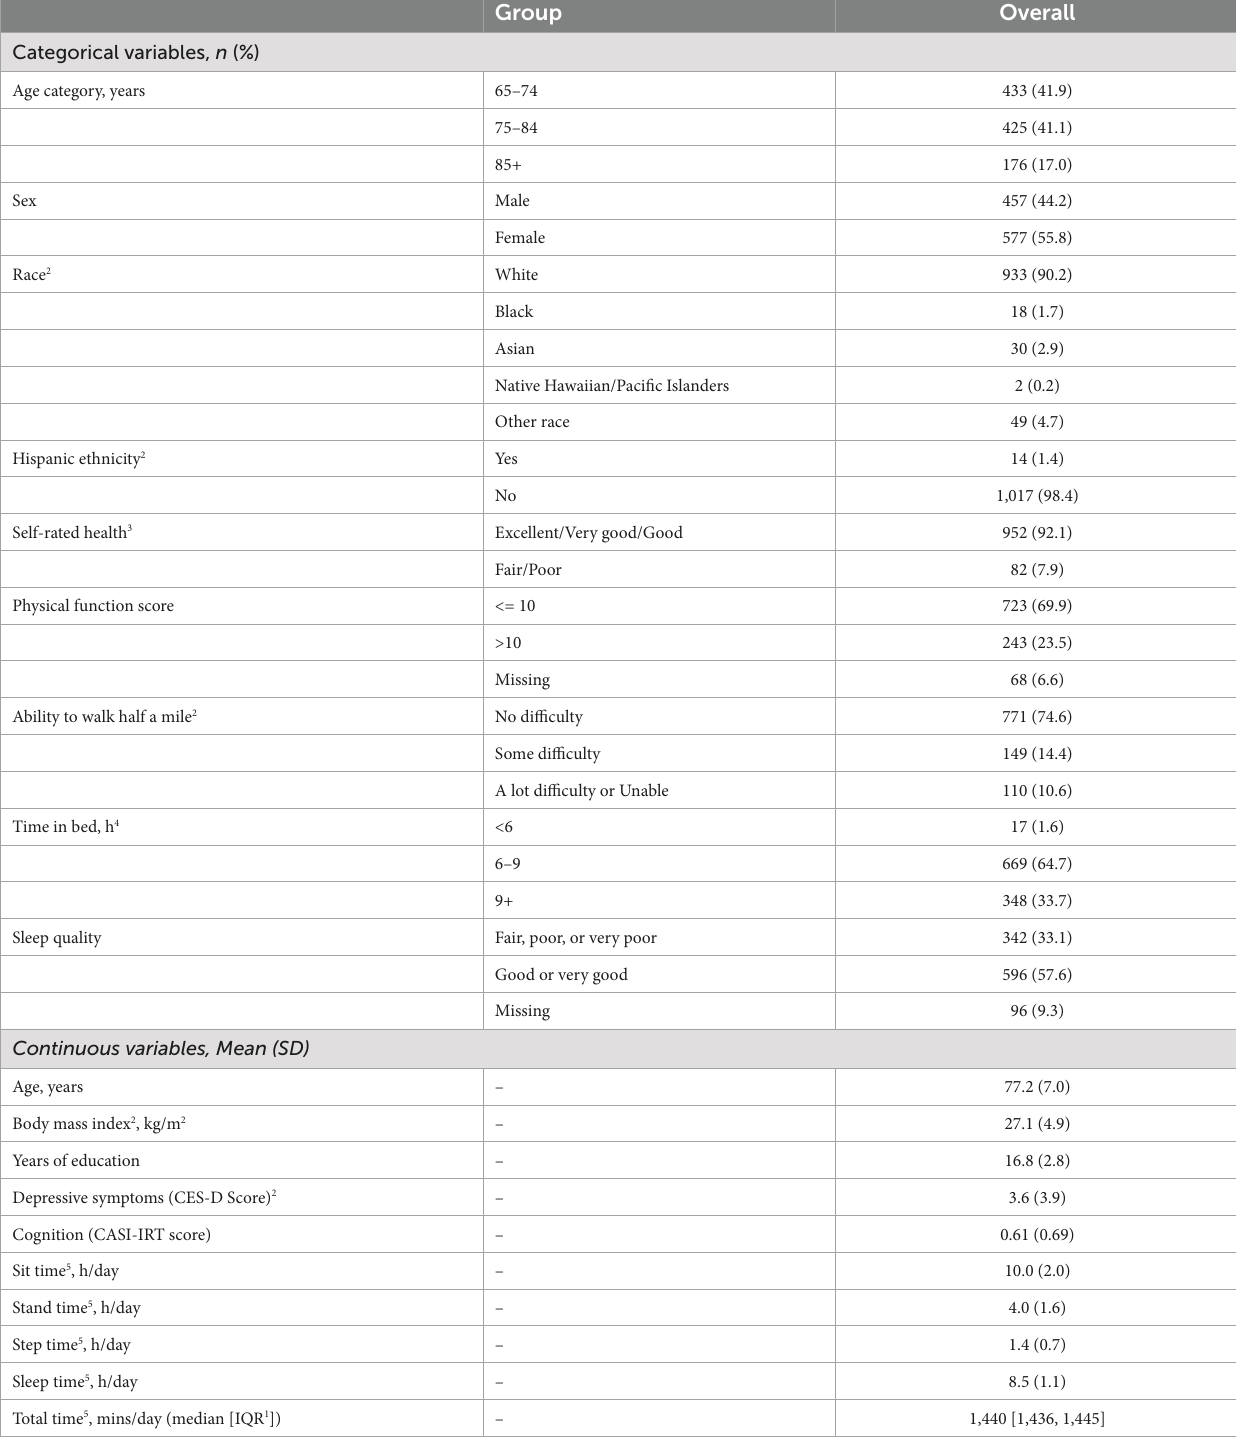
TABLE 1 Descriptive statistics for the ACT 24-h Activity Study ( N = 1,034).